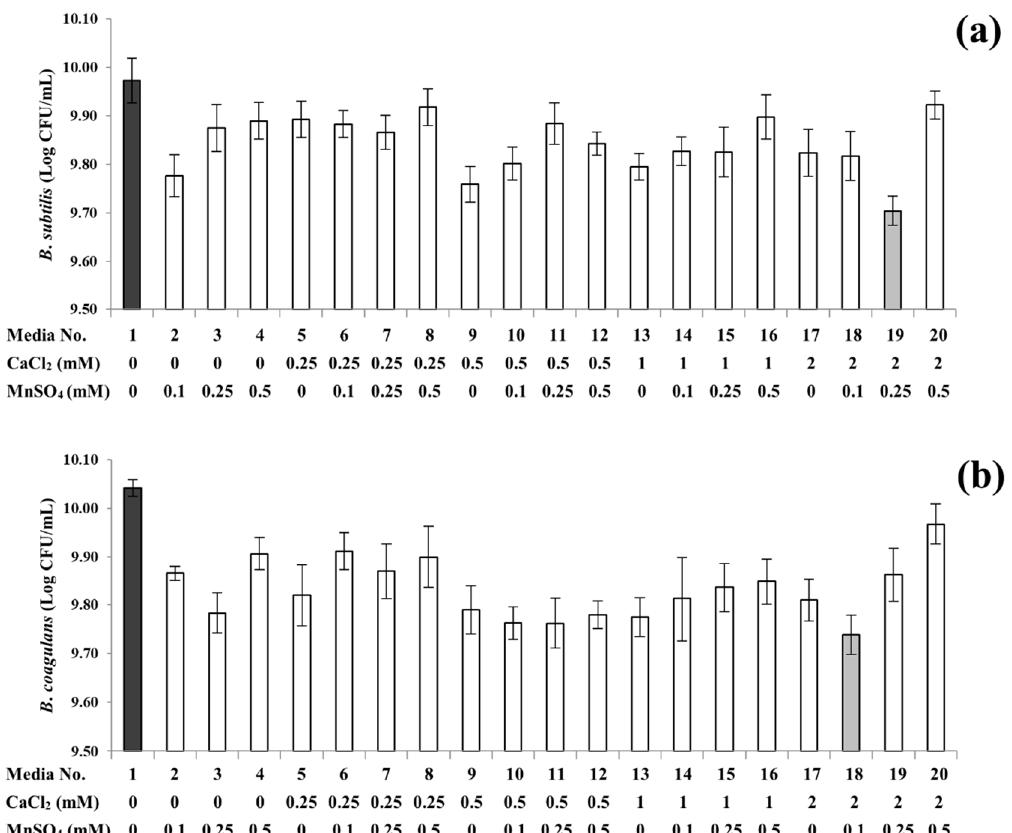
Figure 2. Sporulation profiles of B . subtilis ( a ) and B . coagulans ( b ) under 20 different supplementation conditions. The light grey and dark grey columns highlight the lowest and highest spore yields, respectively. Error bars indicate standard deviations calculated from triplicate experiments.